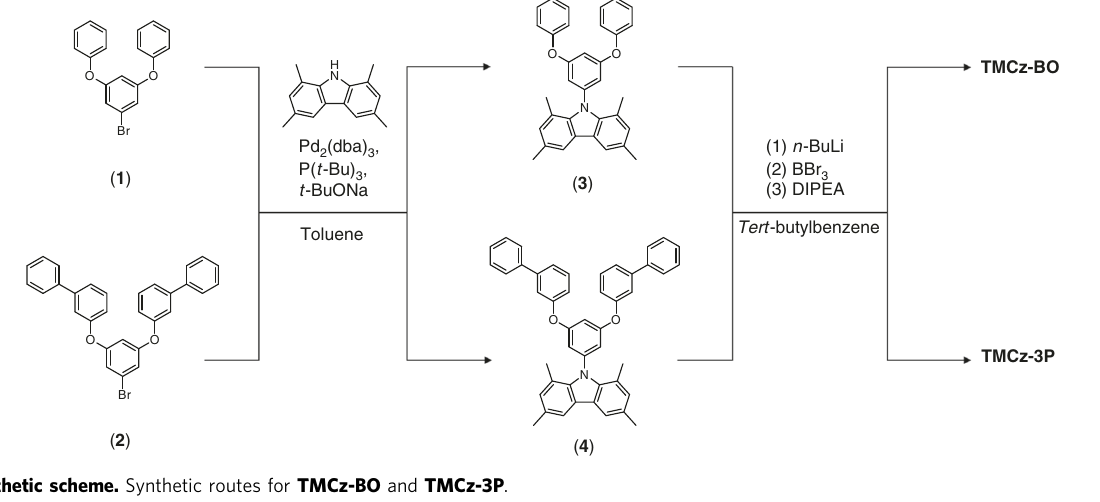
Fig. 2 Synthetic scheme. Synthetic routes for TMCz-BO and TMCz-3P .